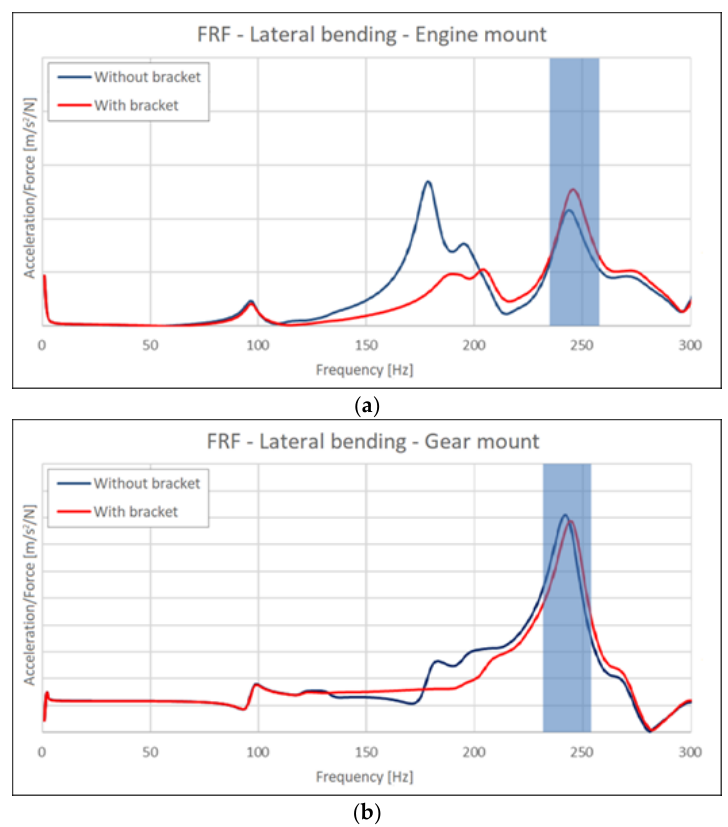
Figure 5. Acceleration / force ratio for the full FEM model for the lateral bending load case with and without the crankcase–gearbox bracket (shown in Figure 3) at: ( a ) engine mount; ( b ) gear mount.